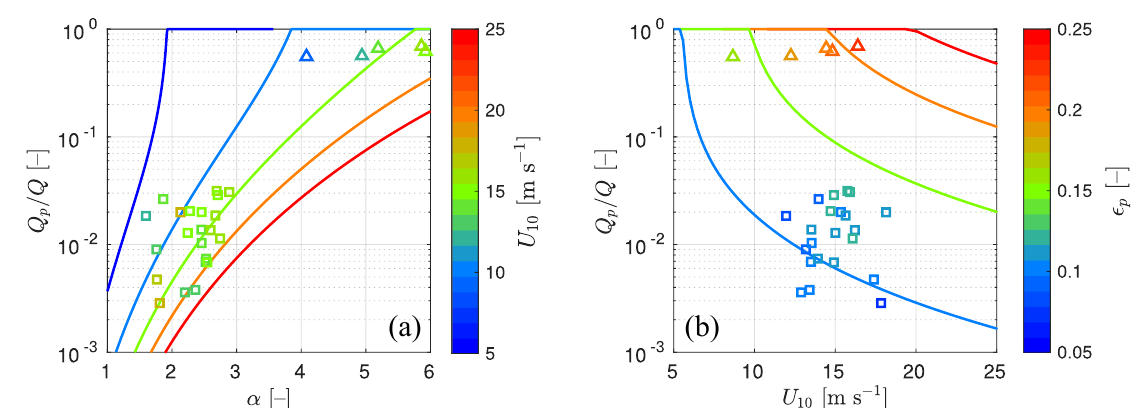
Figure 7. ( a ) The contribution of dominant waves to the observed total active whitecap coverage, Q , as a function of the inverse wave age, α . ( b ) The same, but as a function of the wind speed, U 10 . Squares and triangles correspond to the onshore- and offshore-wind conditions, respectively. Lines indicate calculations from a semi-empirical model of Q , introduced in Section 4, for different U 10 and dominant wave steepness, (cid:101) p .